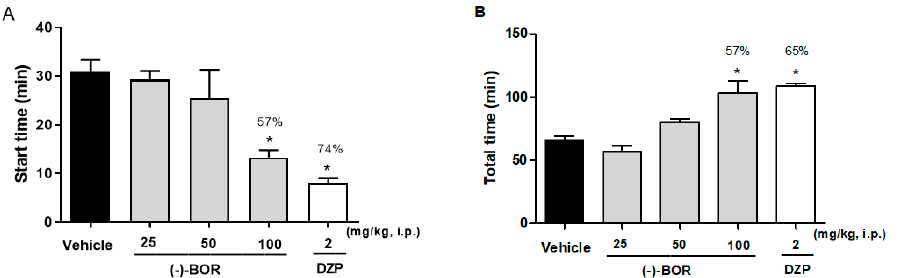
Figure 5. The effect of (–)-BOR (25, 50, and 100 mg/kg, i.p.) and DZP (2 mg/kg, i.p.) on the thiopental sodium-induced sleeping time test in Swiss mice ( n = 6). Each bar represents the mean ± S.E.M of sleep onset time ( A ) or total sleep duration time ( B ) in minutes (min). * p < 0.05 was significant compared to the vehicle group (ANOVA and Student-Newman-Keuls test as the post hoc test).